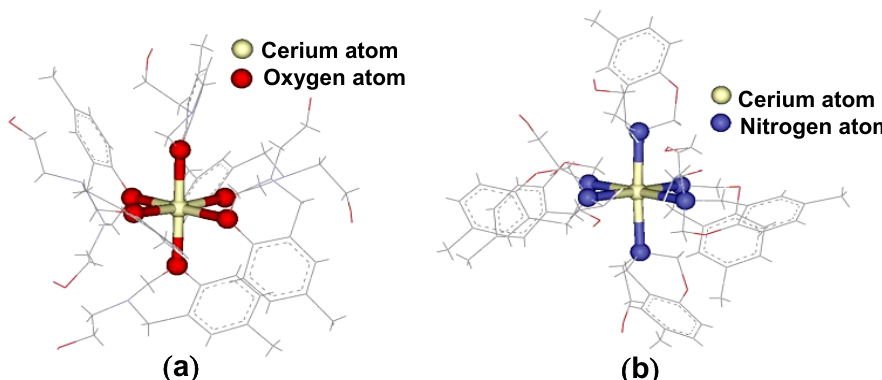
Figure 11. Orientation of ( a ) Ce-O and ( b ) Ce-N